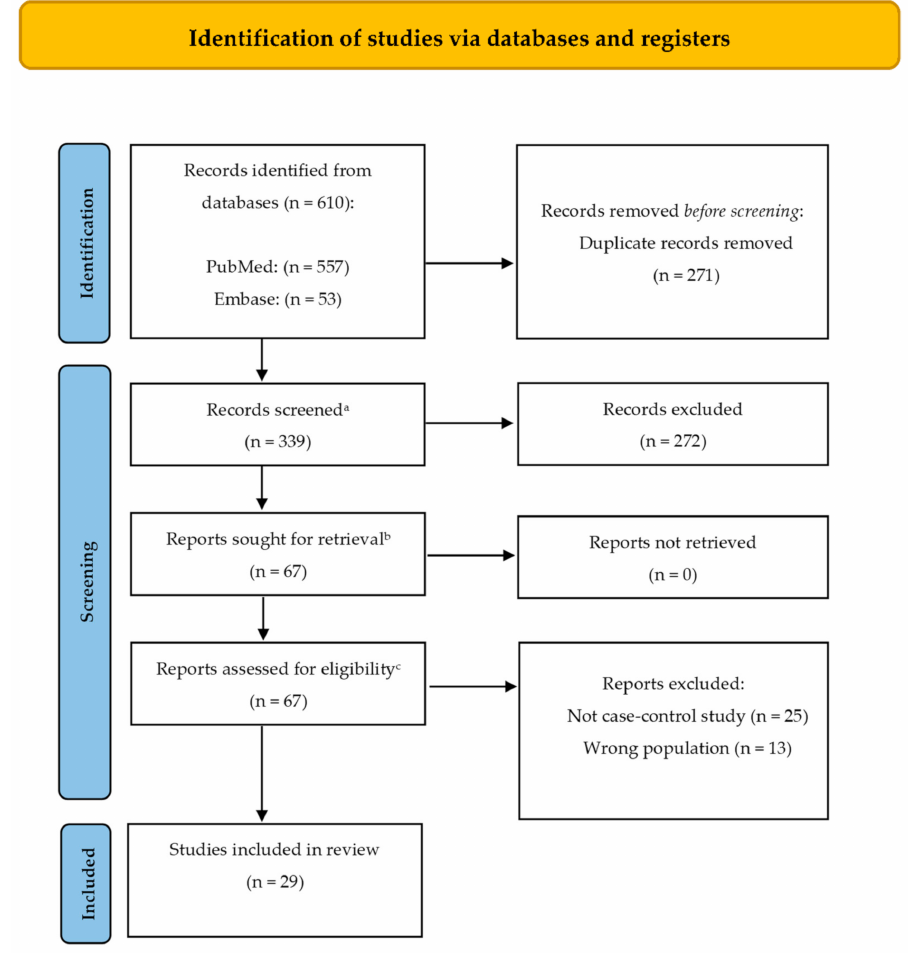
Figure 1. PRISMA (Preferred Reporting Items for Systematic Reviews and Meta-Analyses) 2020 flow diagram representing the searching and selection process for this review [15]. a This is the number of records identified minus the number from the duplicates removed box; b This is the number of articles obtained in preparation for full text screening (subtract the number of excluded records